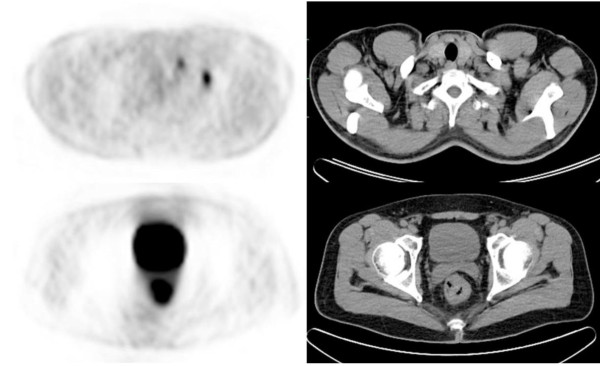
Appearance of primary tumor and left supraclavicular lymph node metastases in PET/CT image.